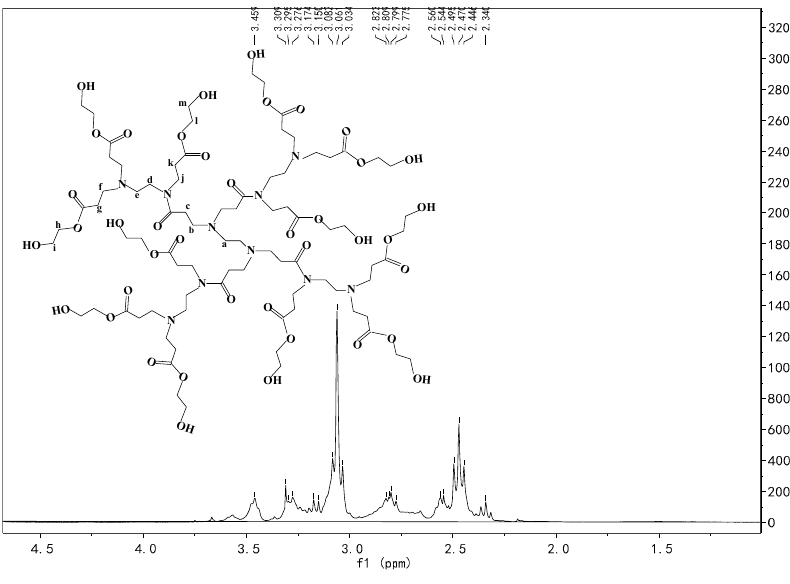
Figure A3. 1 H NMR spectrum of pre-AgHBP-A (AgHBP-A).